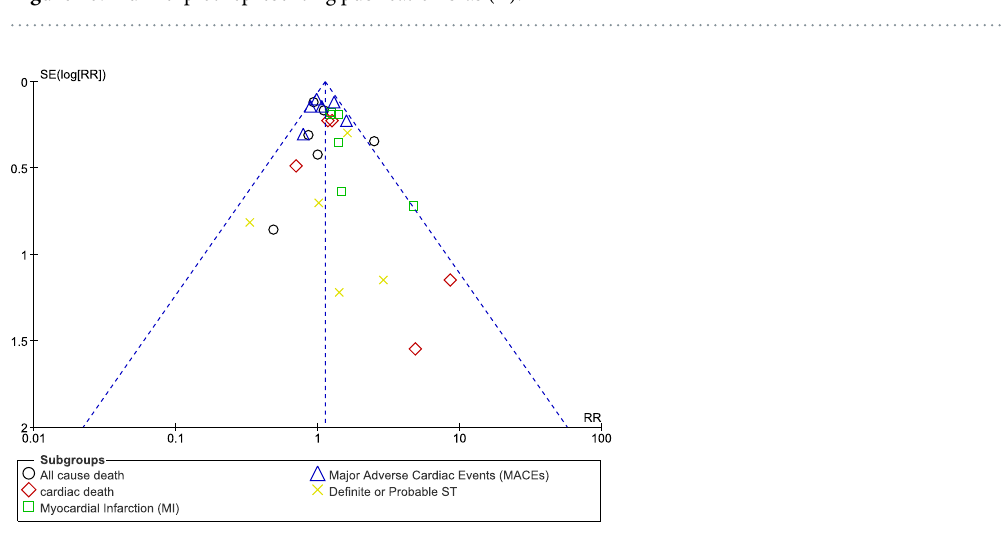
Figure 17. Funnel plot representing publication bias ( C